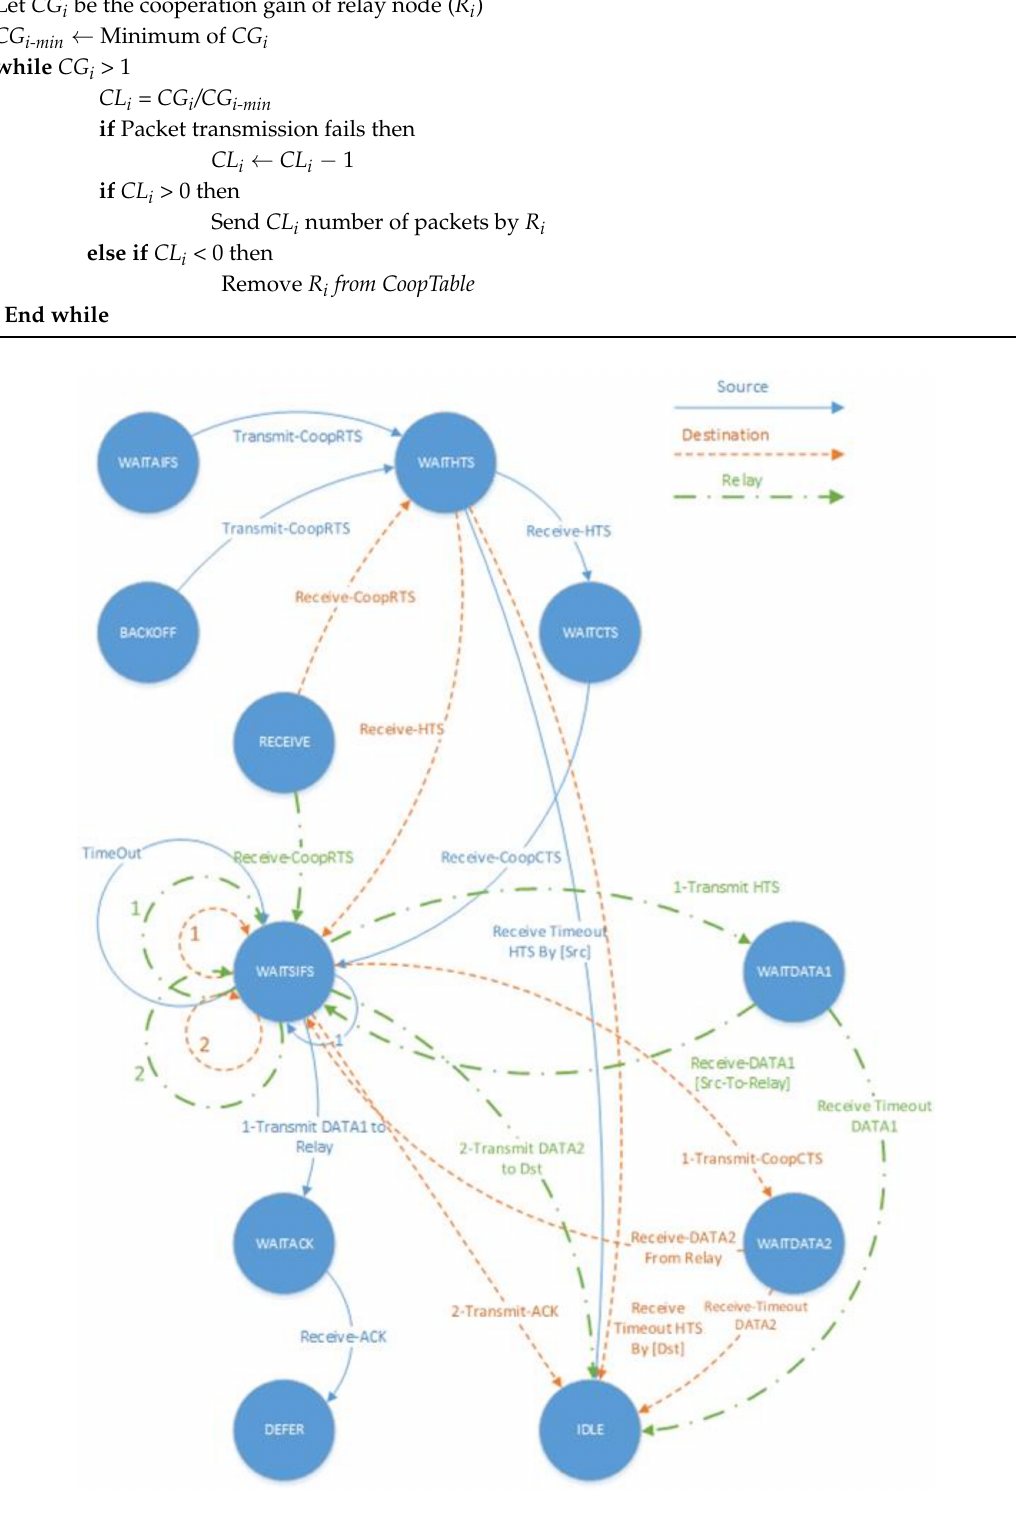
Figure 2. Finite State Machine of the FC-MAC